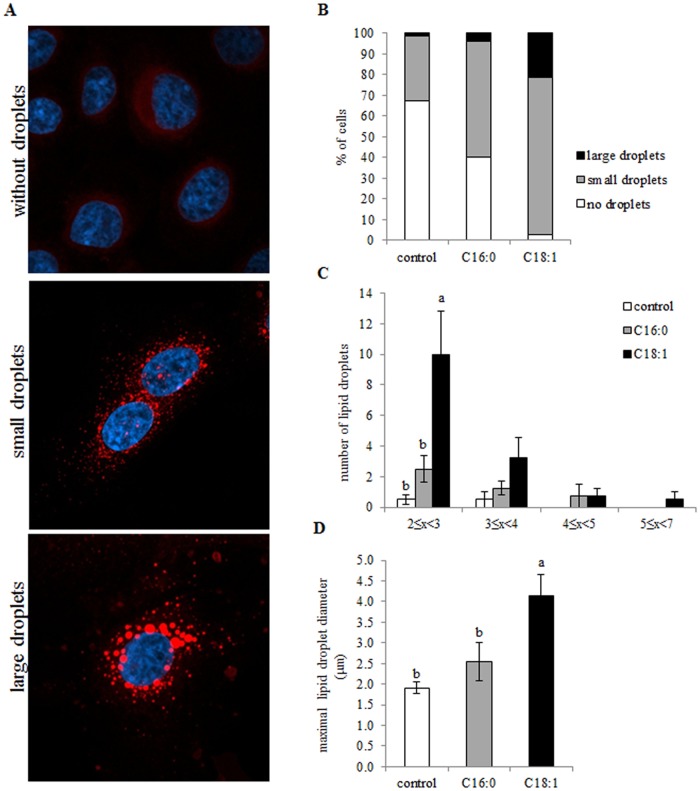
Intracellular lipid droplet size is altered by the presence of various free fatty acids (FFAs) in the culture medium.After cultivating mammary epithelial cells with 100 μM FFA (palmitic or oleic acid) or with FFA-free medium (control) for 24 h, lipid droplets were stained with Nile red. (A) Representative images showing the cellular phenotype according to the presence and size of cytoplasmic lipid droplets. Cells were categorized into three groups according to their lipid droplet phenotype: without lipid droplets, with small lipid droplets, or with large lipid droplets. Scale bar = 10 μm. (B) Distribution of mammary epithelial cells with different lipid droplet phenotypes was analyzed by chi-square test (P> 0.05). (C) Number of lipid droplets, by size categories. (D) Maximal lipid droplet diameter. In C and D, data are presented as mean ± SEM and different letters indicate significant differences between treatment groups (P < 0.05).